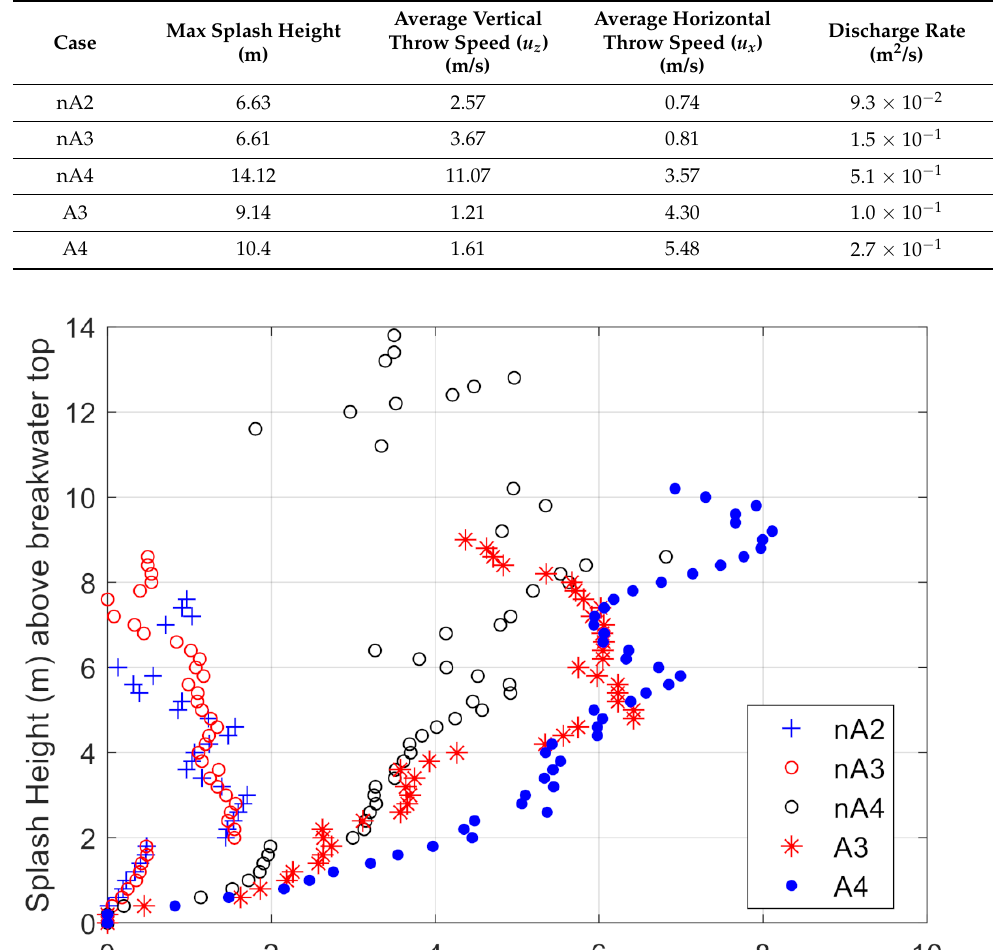
Table 3. Simulation results: max splash height and average throw speed.